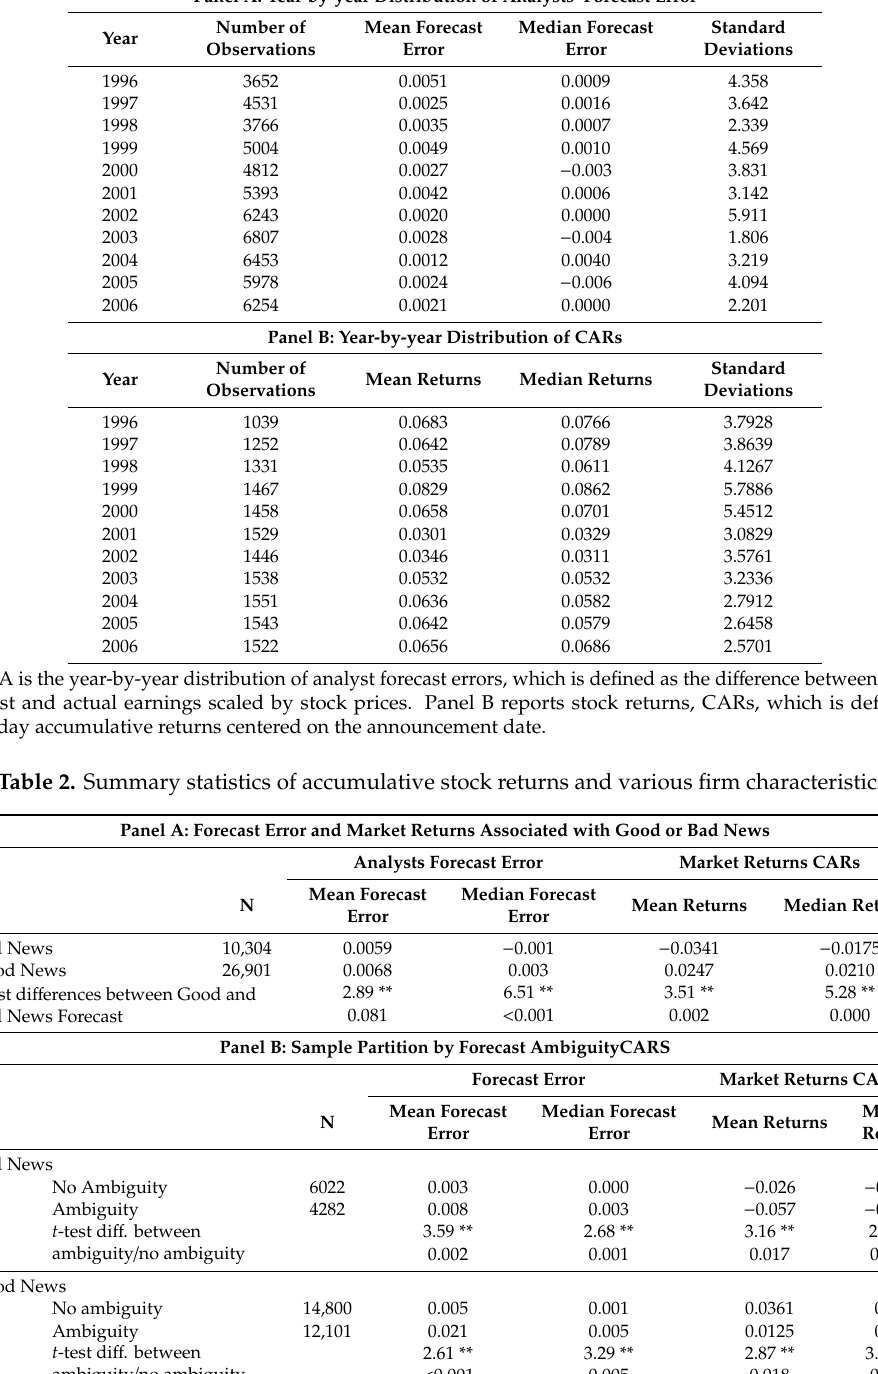
Table 1. Year-by-year distribution of analyst forecast errors and accumulative stock returns. Panel A: Year-by-year Distribution of Analysts’ Forecast Error